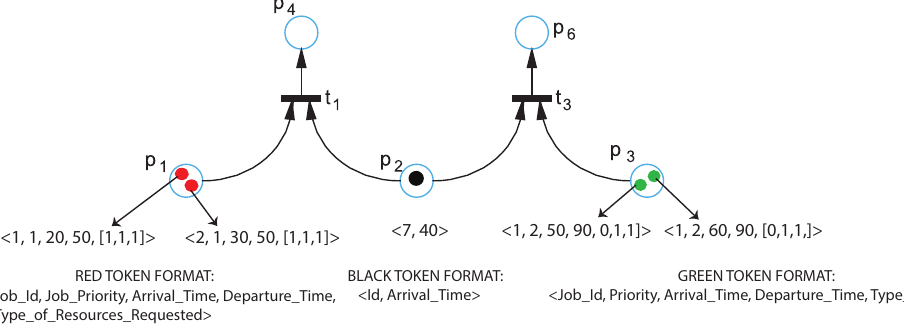
Figure 5. Transition firing time